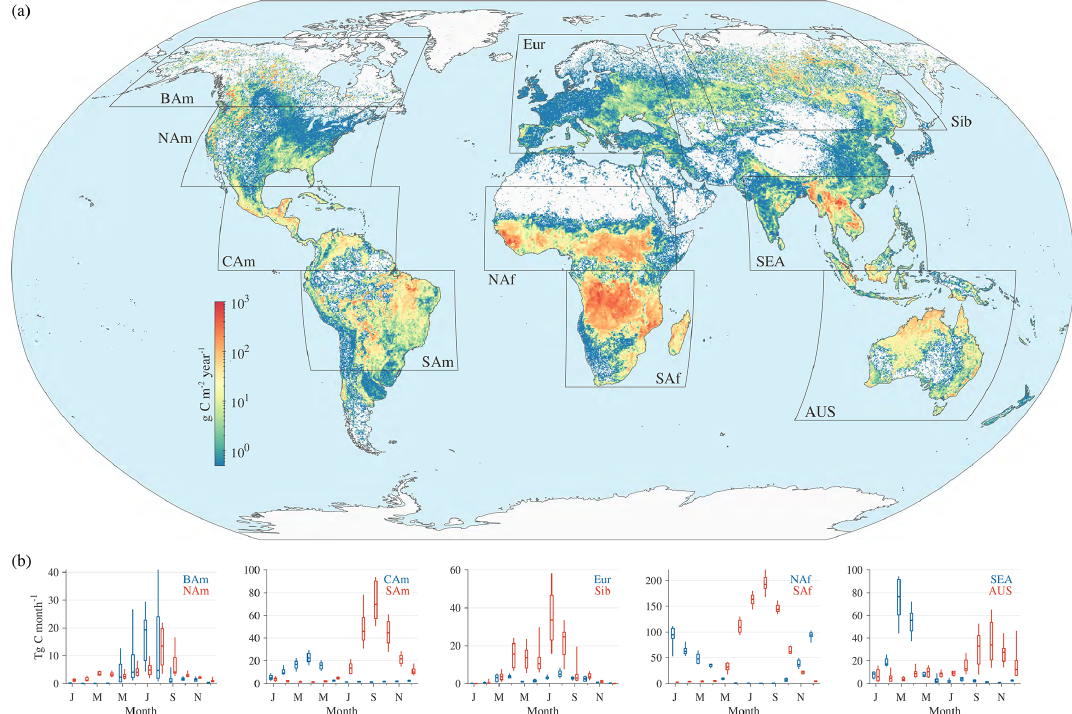
Figure 2. (a) Average annual carbon emissions (gm − 2 a − 1 ) from VFEI between 2012 and 2019. Polygons show the regions defined to compare VFEI to other inventories. (b) Annual cycle of carbon emissions in each region (Tg per month) defined in Table 3 and shown in (a) . The lower (upper) boundary of the box plots represents the 25th (75th) percentile, the mid-line in the box represents the median, and the bottom and top of the vertical lines represent the 10th and 90th percentile,